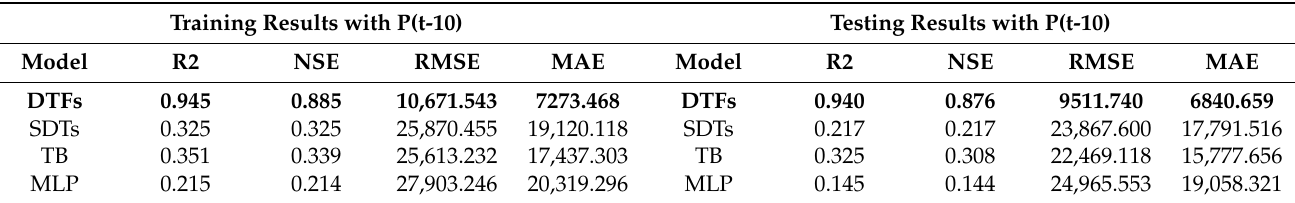
Table 10. Training and testing results with Q(t-10) of different data mining